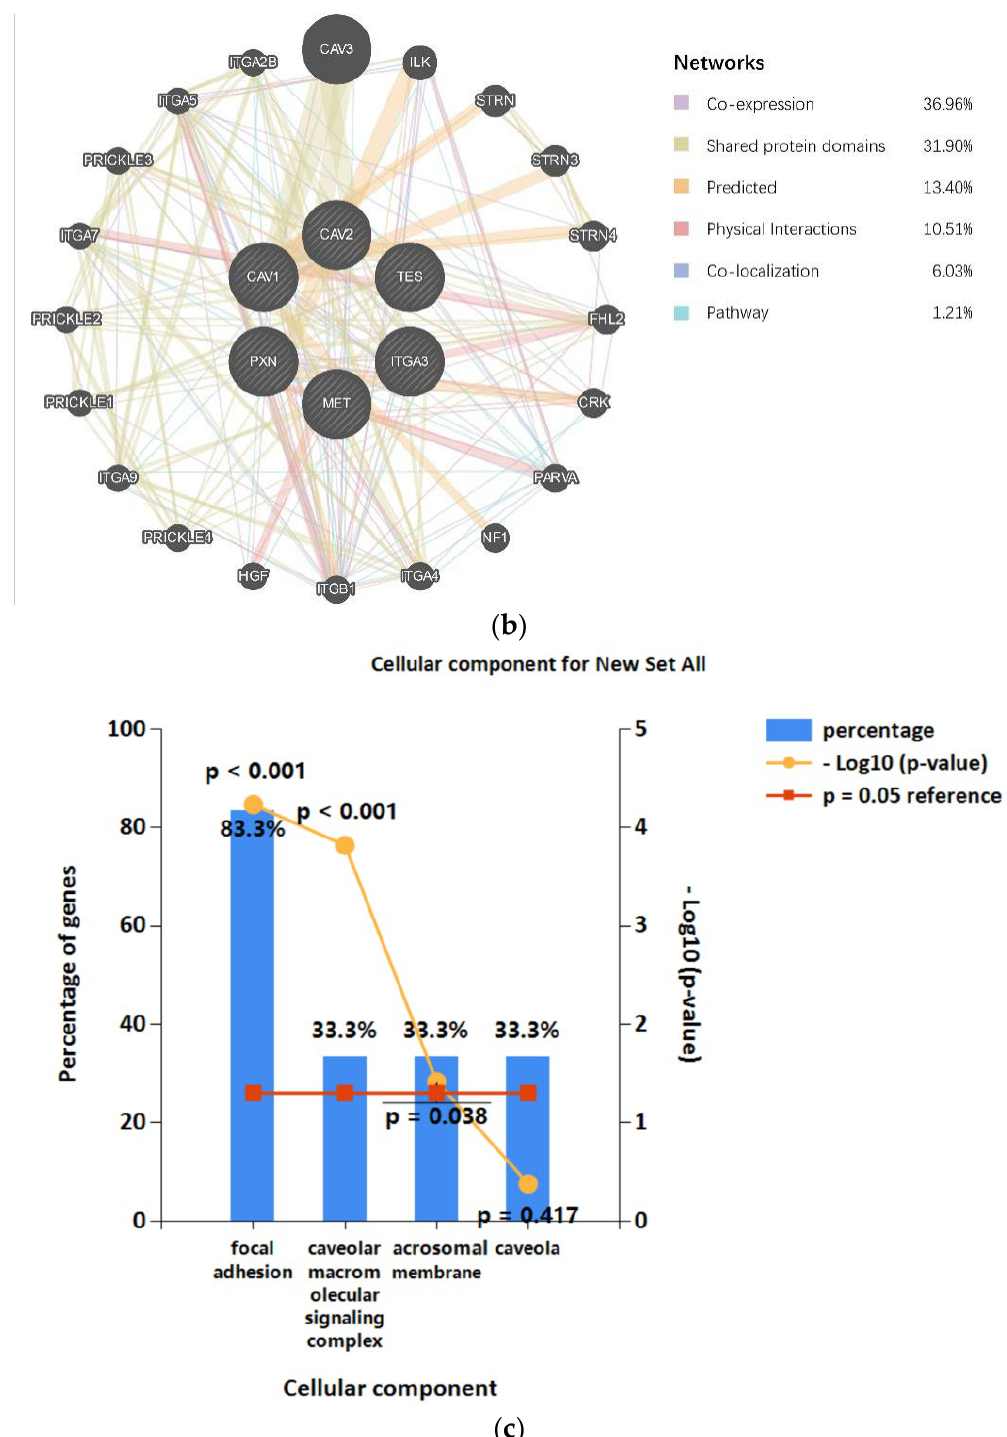
Figure 7. Potential regulatory network of CAV1 and CAV2 in HNSCC ( a ). Heatmap showing the expression profile of four high-potential candidate genes. Interconnections between proteins are explored in terms of co-expression, shared protein domains, predicted physical interactions, colocalization and pathway ( b ). In the GO domain of cellular component, significant enrichment was found in focal adhesion (Bonferroni method p -value < 0.001), which demonstrates that the gene products of CAV1 and CAV2 and co-expression genes may be located at focal adhesion ( c ).